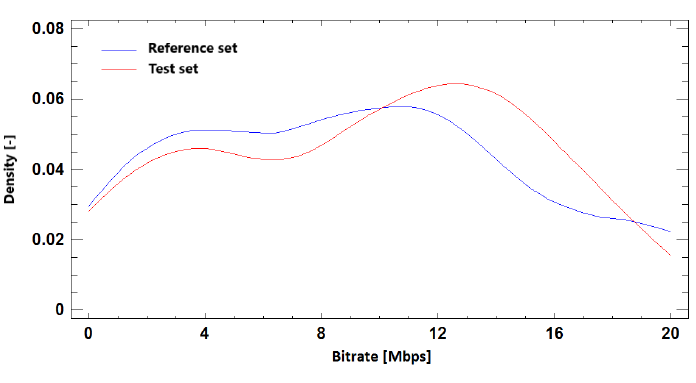
Figure 23. The probability density function for bitrate prediction based on SSIM, Ultra HD , H.264 + H.265.